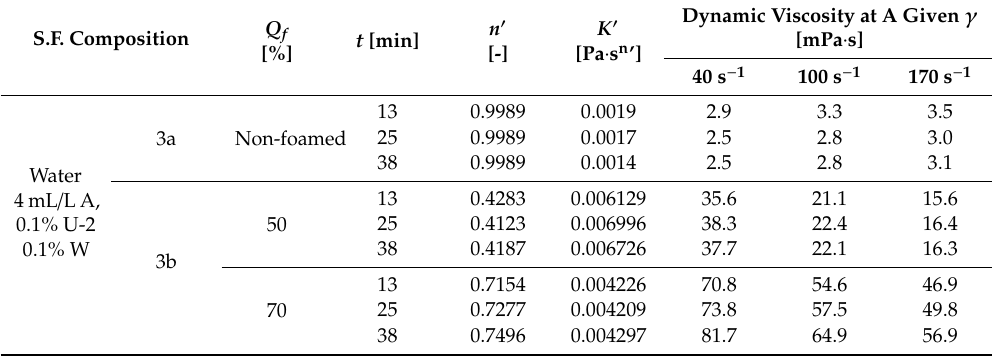
Table 3. Rheological parameters of fluids energized with N 2 with the application of U-2 nanoadditive and natural polymer, foam quality of 50% and 70%.